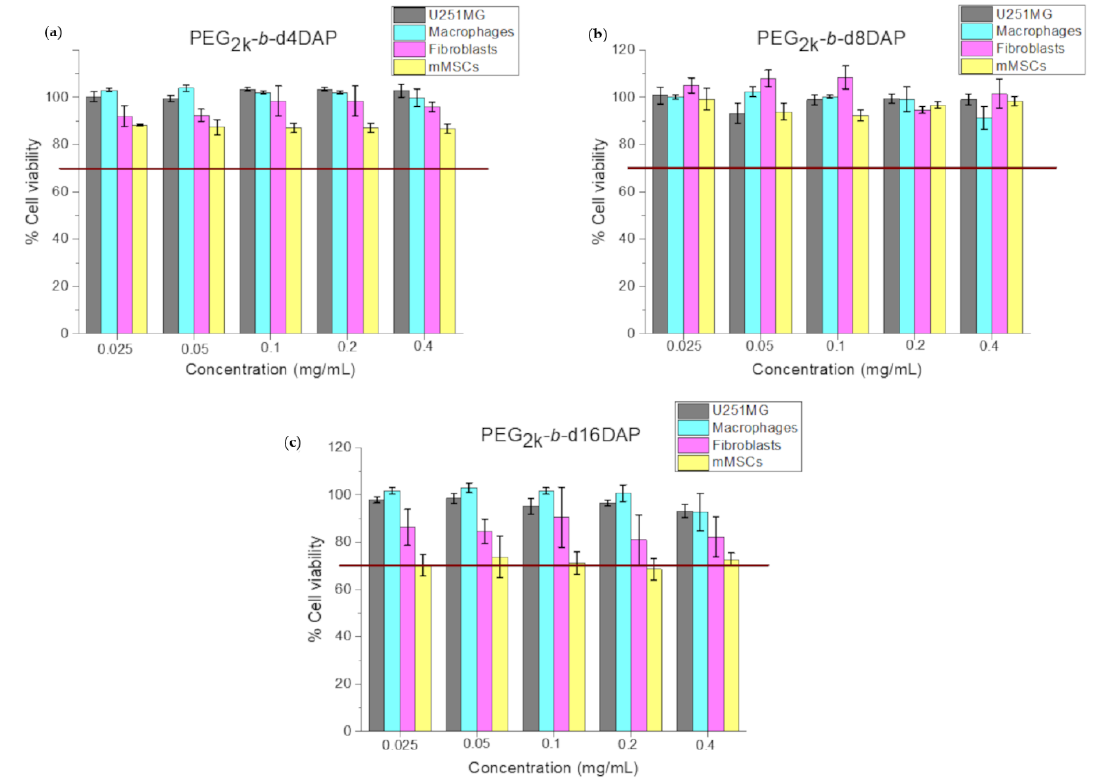
Figure 4. Cell viability of self-assemblies dispersion of LDBCs prepared by microfluidics (A, Table 3) adjusted at different polymer concentrations: ( a ) PEG 2k - b -d4DAP , ( b ) PEG 2k - b -d8DAP , and ( c ) PEG 2k - b -d16DAP in the four cell lines assayed after 24 h. Red lines correspond to 70% cell viability, which is the minimum recommended for considering a subcytotoxic concentration according to ISO 10993-5